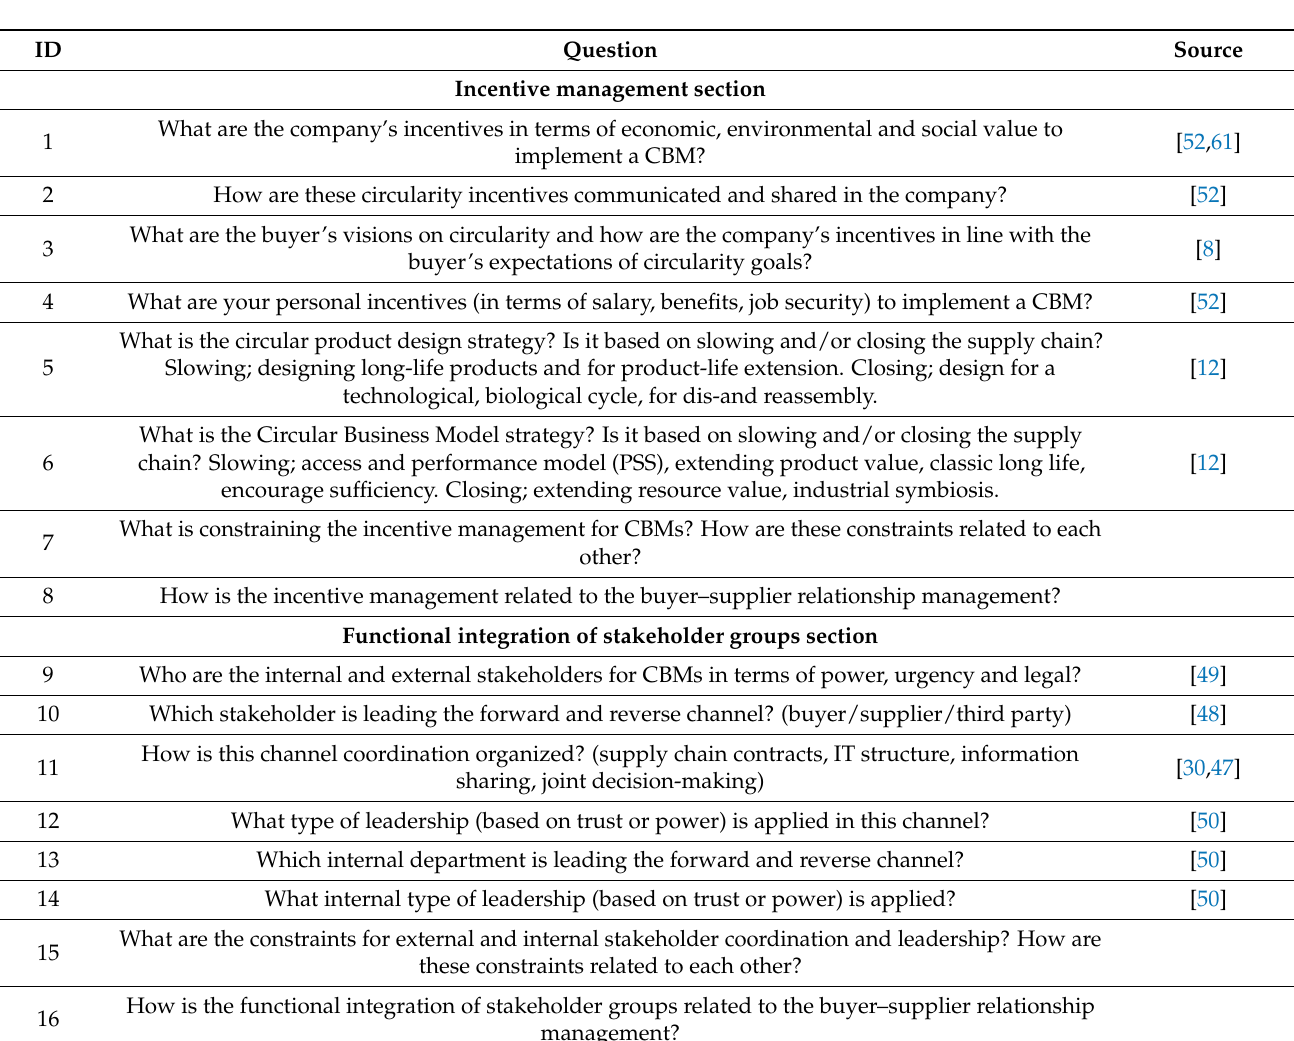
Table A2. Interview